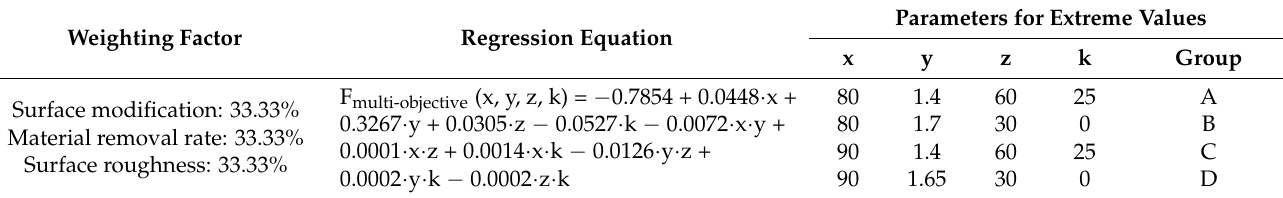
Table 5. Optimization equation and suggested parameter